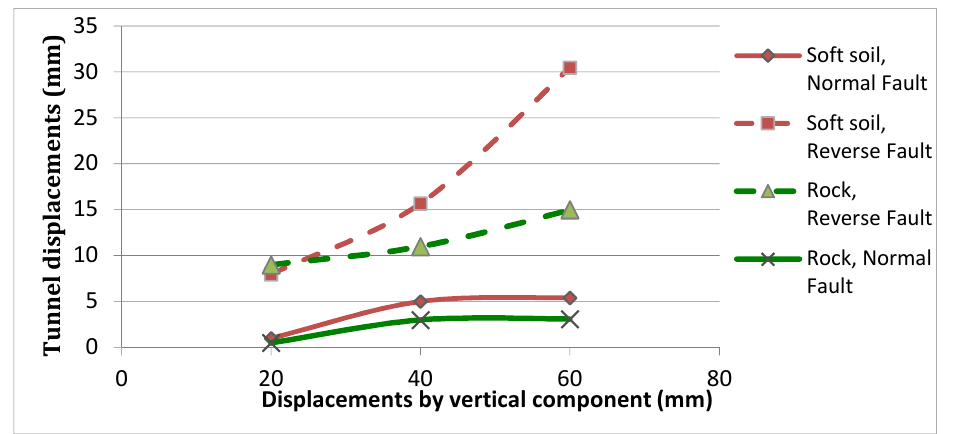
Figure 13. Comparison between rock and soft soil in a field affected by normal and reverse faults.